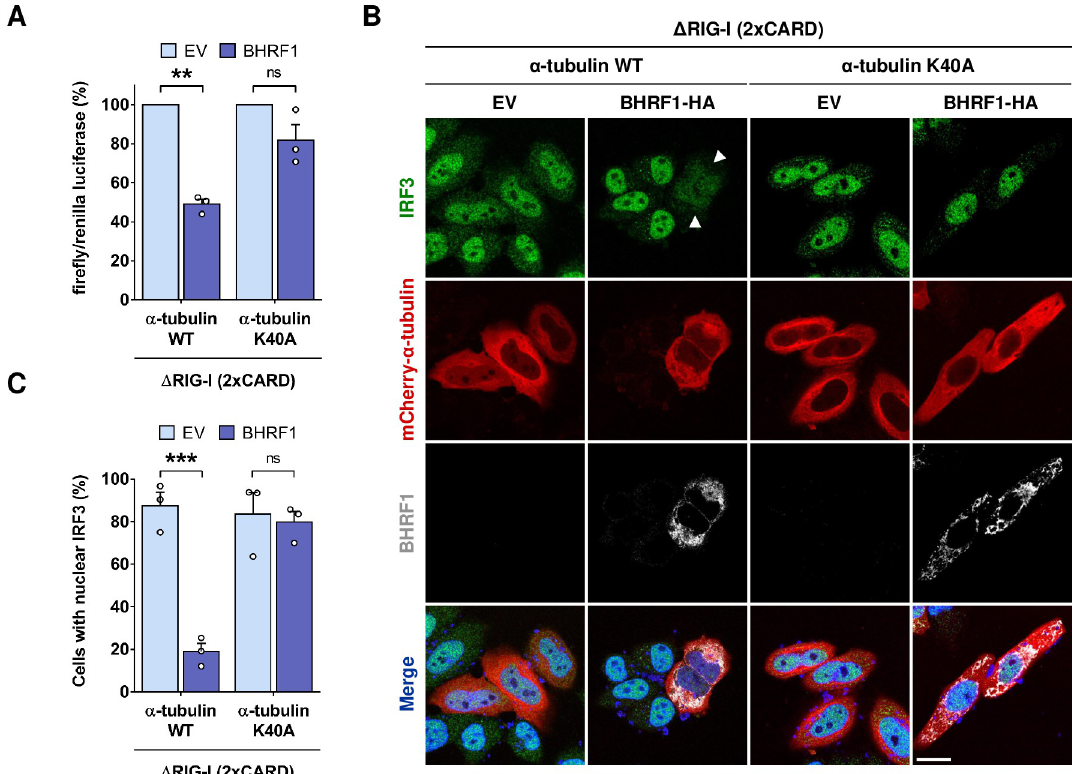
Fig 4. MT hyperacetylation is required for BHRF1 to block IFN. (A) Luciferase reporter assay on HEK293T cells co-expressing BHRF1 (or EV) and α -tubulin K40A (or WT). Activation of the IFN- β promoter was analyzed 24 h post-transfection. Firefly/renilla luciferase ratios were calculated and normalized to control conditions. (B-C) HeLa cells were co-transfected for 24 h with plasmids encoding BHRF1-HA (or EV), mCherry- α -tubulin K40A (or WT), and Δ RIG-I (2xCARD). (B) Confocal images. BHRF1-HA- transfected cells were visualized with an anti-HA antibody and cells were immunostained with an-anti IRF3 antibody. Nuclei were stained with DAPI. Scale bar: 20 μ m. Arrows indicate BHRF1-expressing cells without IRF3 nuclear localization. (C) Percentage of cells expressing mCherry- α -tubulin and presenting IRF3 nuclear localization (n = 50 cells per condition). Data represent the mean ± SEM of three independent experiments. ns = non-significant; �� P < 0.01; ��� P < 0.001 (Student’s t-test).